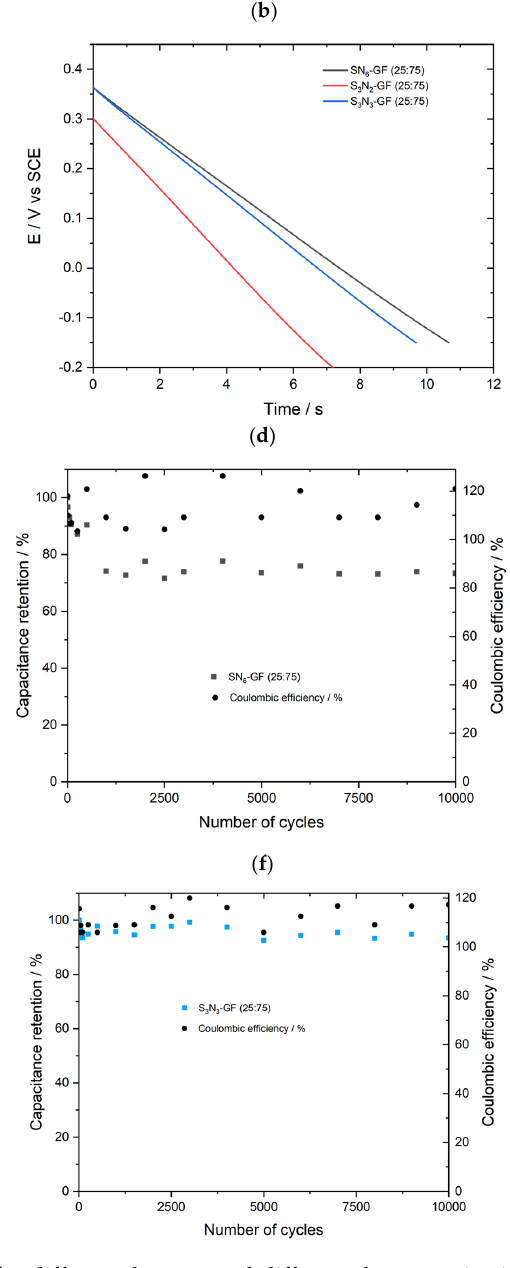
Table 5. Summary of specific capacitance values obtained for the different co ‐ doped materials pre ‐ pared in this study at different applied specific currents in 1 M KOH.